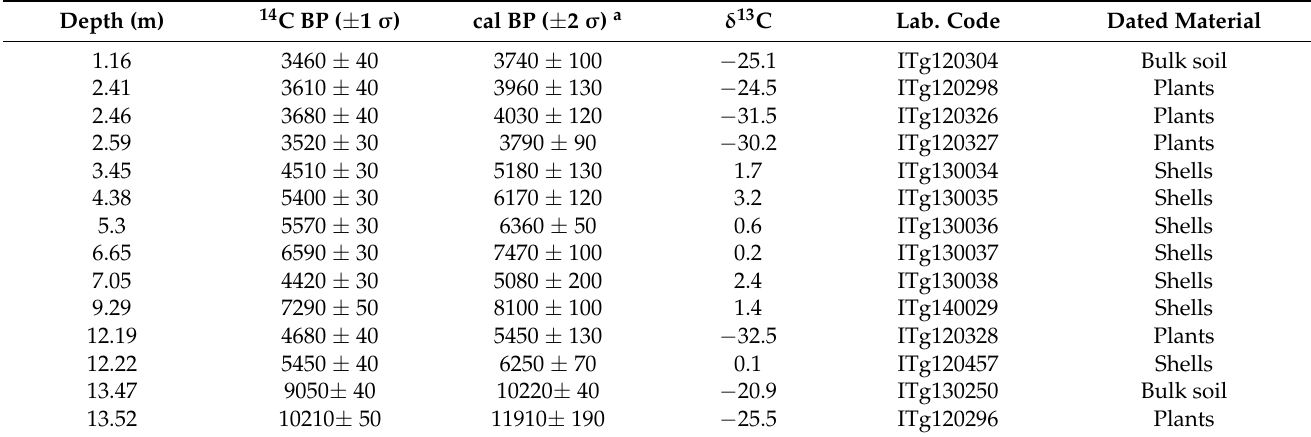
Table 1. Results of AMS 14 C dating and calibrated dates for core